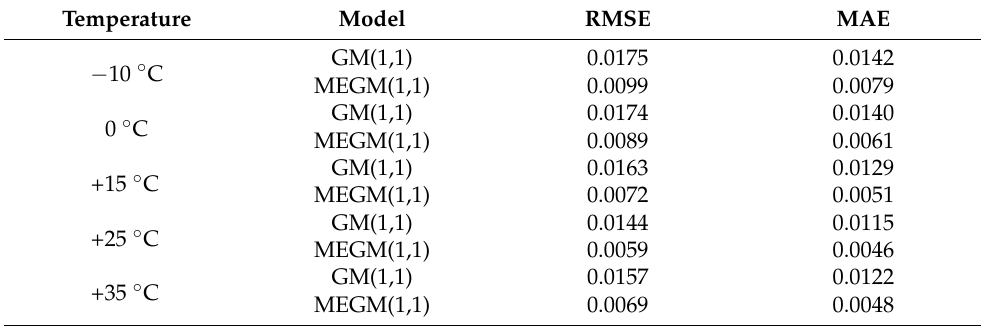
Table 3. Estimation analysis for GM(1,1) and MEGM(1,1) after convergence under